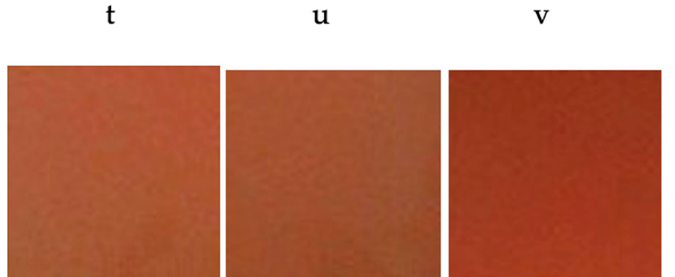
Figure 16. Color development of glazed tiles with pigment Y 0.98 Al 0.98 Cr 0.04 O 3 with flux agent mixture